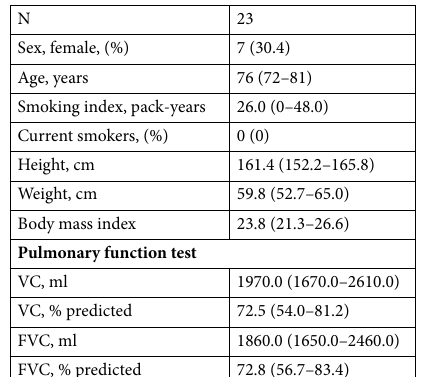
Table 1. Clinical features of the study population. Data are presented as median (IQR) or number (%). VC vital capacity, FVC forced vital capacity.